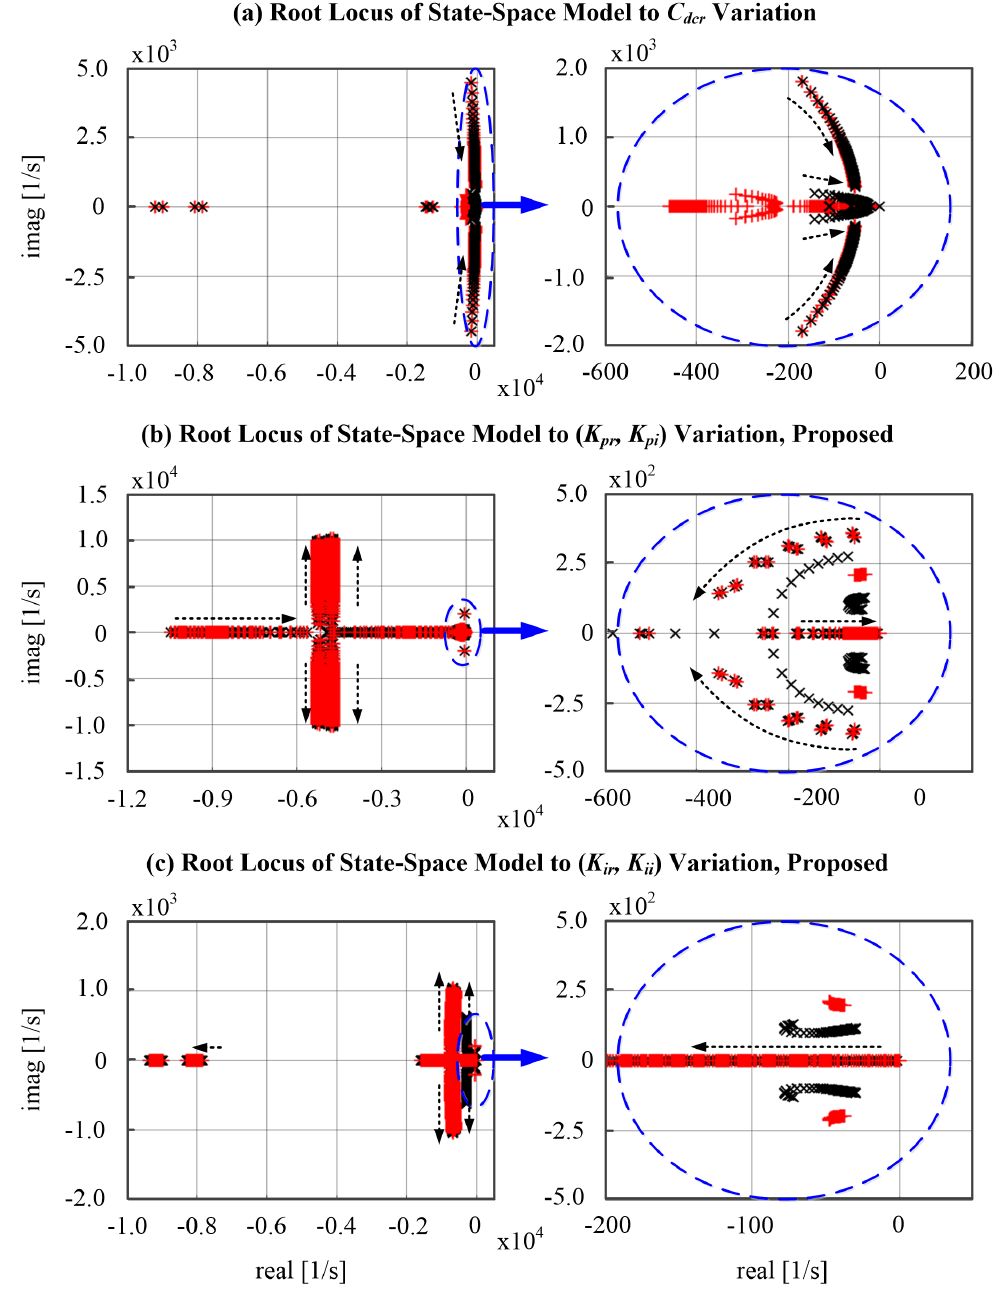
Figure 6. Eigenvalue locations for the proposed method with ( a ) C dcr increasing from 0.0025 to 0.1; ( b ) ( K pr , K pi ) increasing from (0.1, 0.063) to (10, 6.3); and ( c ) ( K ir , K ii ) increasing from (10, 4.13) to (1000,